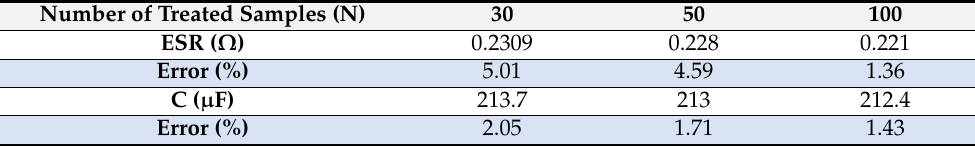
Table 4. Estimated ESR and C at different values of N.